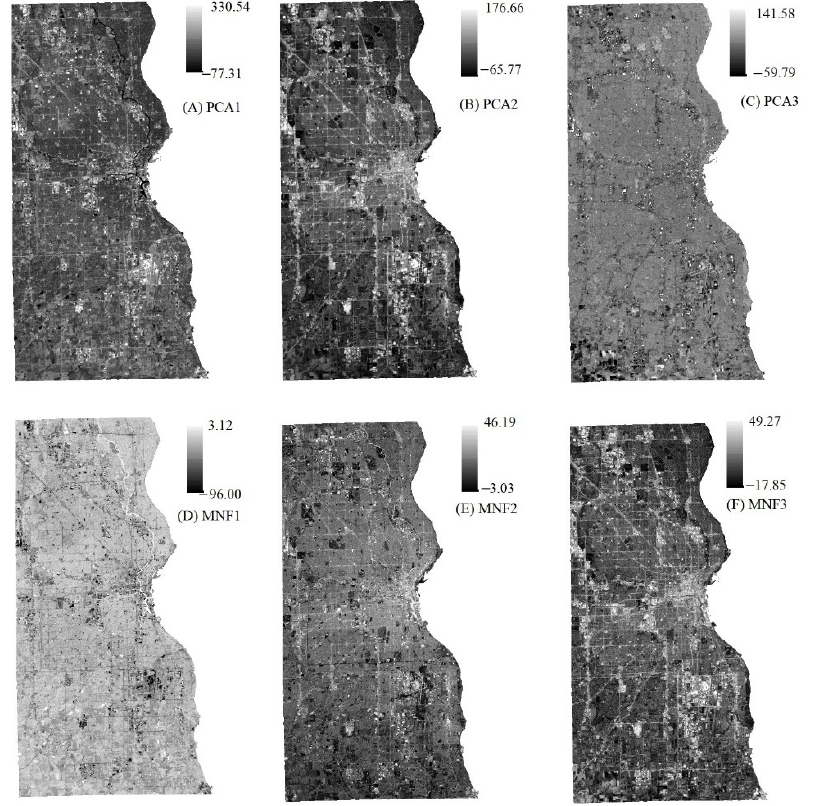
Figure 4. The first three components generated from each of the statistical analysis methods, PCA and MNF.